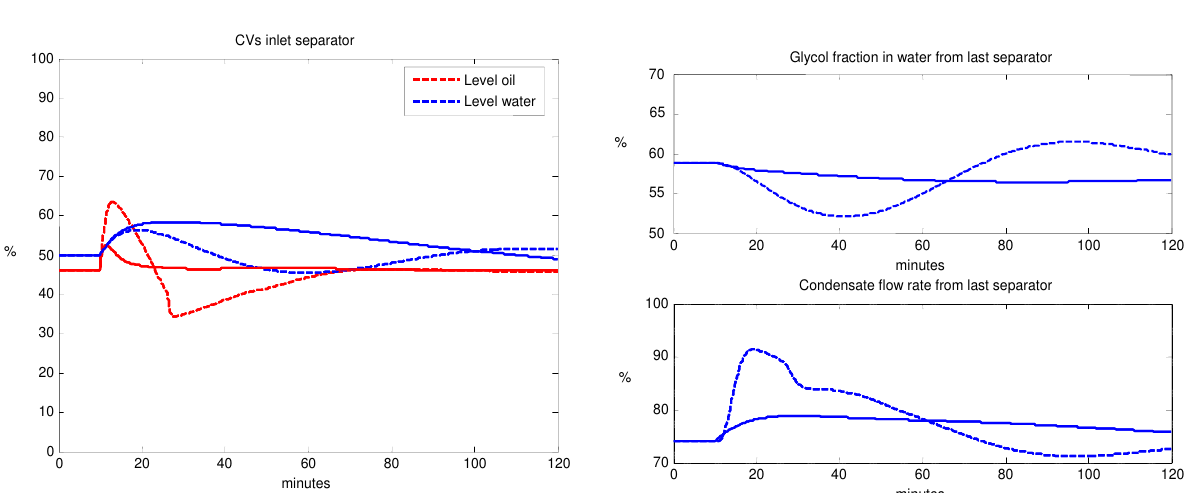
Figure 5: Oil and water levels in the inlet separa- tor, with MPC (solid) and without MPC (dashed).